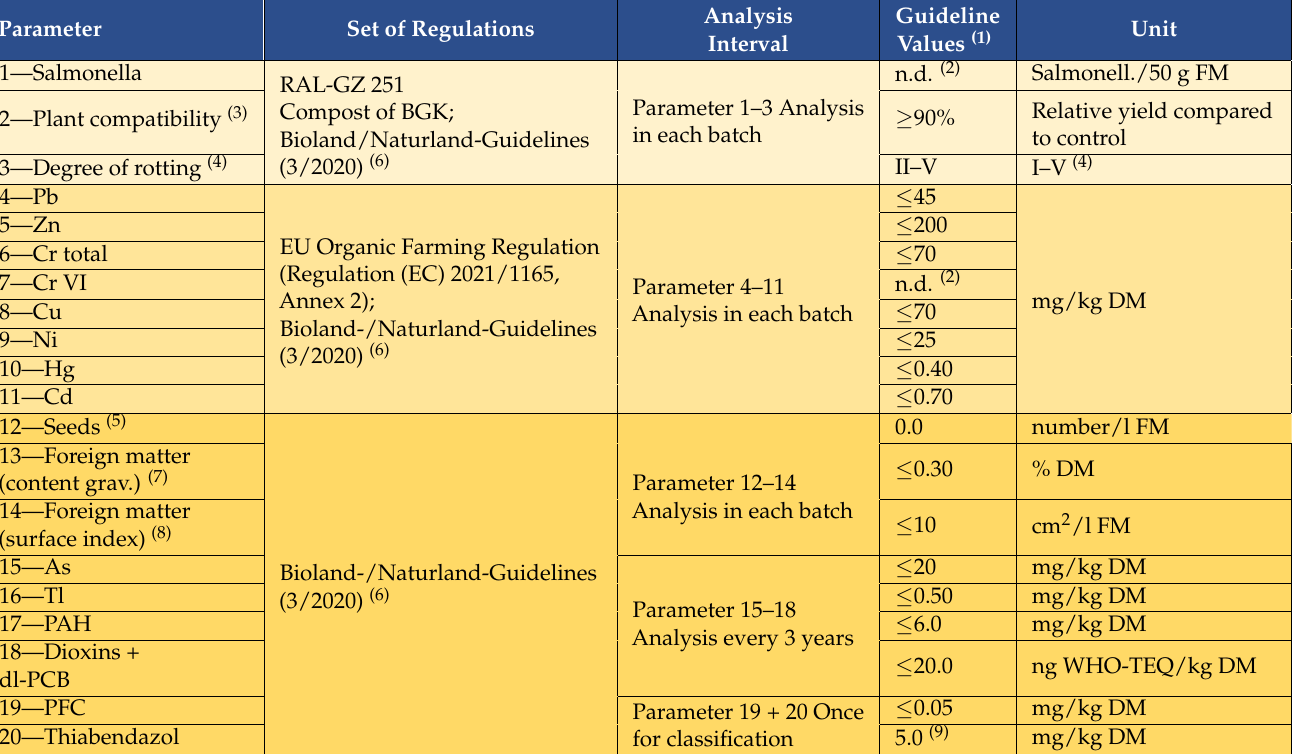
Figure 1. Quality assurance scheme in the determination of suitability of biowaste and green waste composts for use in organic farming in Germany. flow into the private sector guidelines as “co-applicable legal regulations”. Examination of composts according to listed regulations. Table 1. Parameter catalog of legal (EU-ÖkoV) and private law regulations (directives of Bioland/Naturland) as well as their relevant guideline/limit values for the use of biowaste and green waste composts in organic farming in Germany (1) .